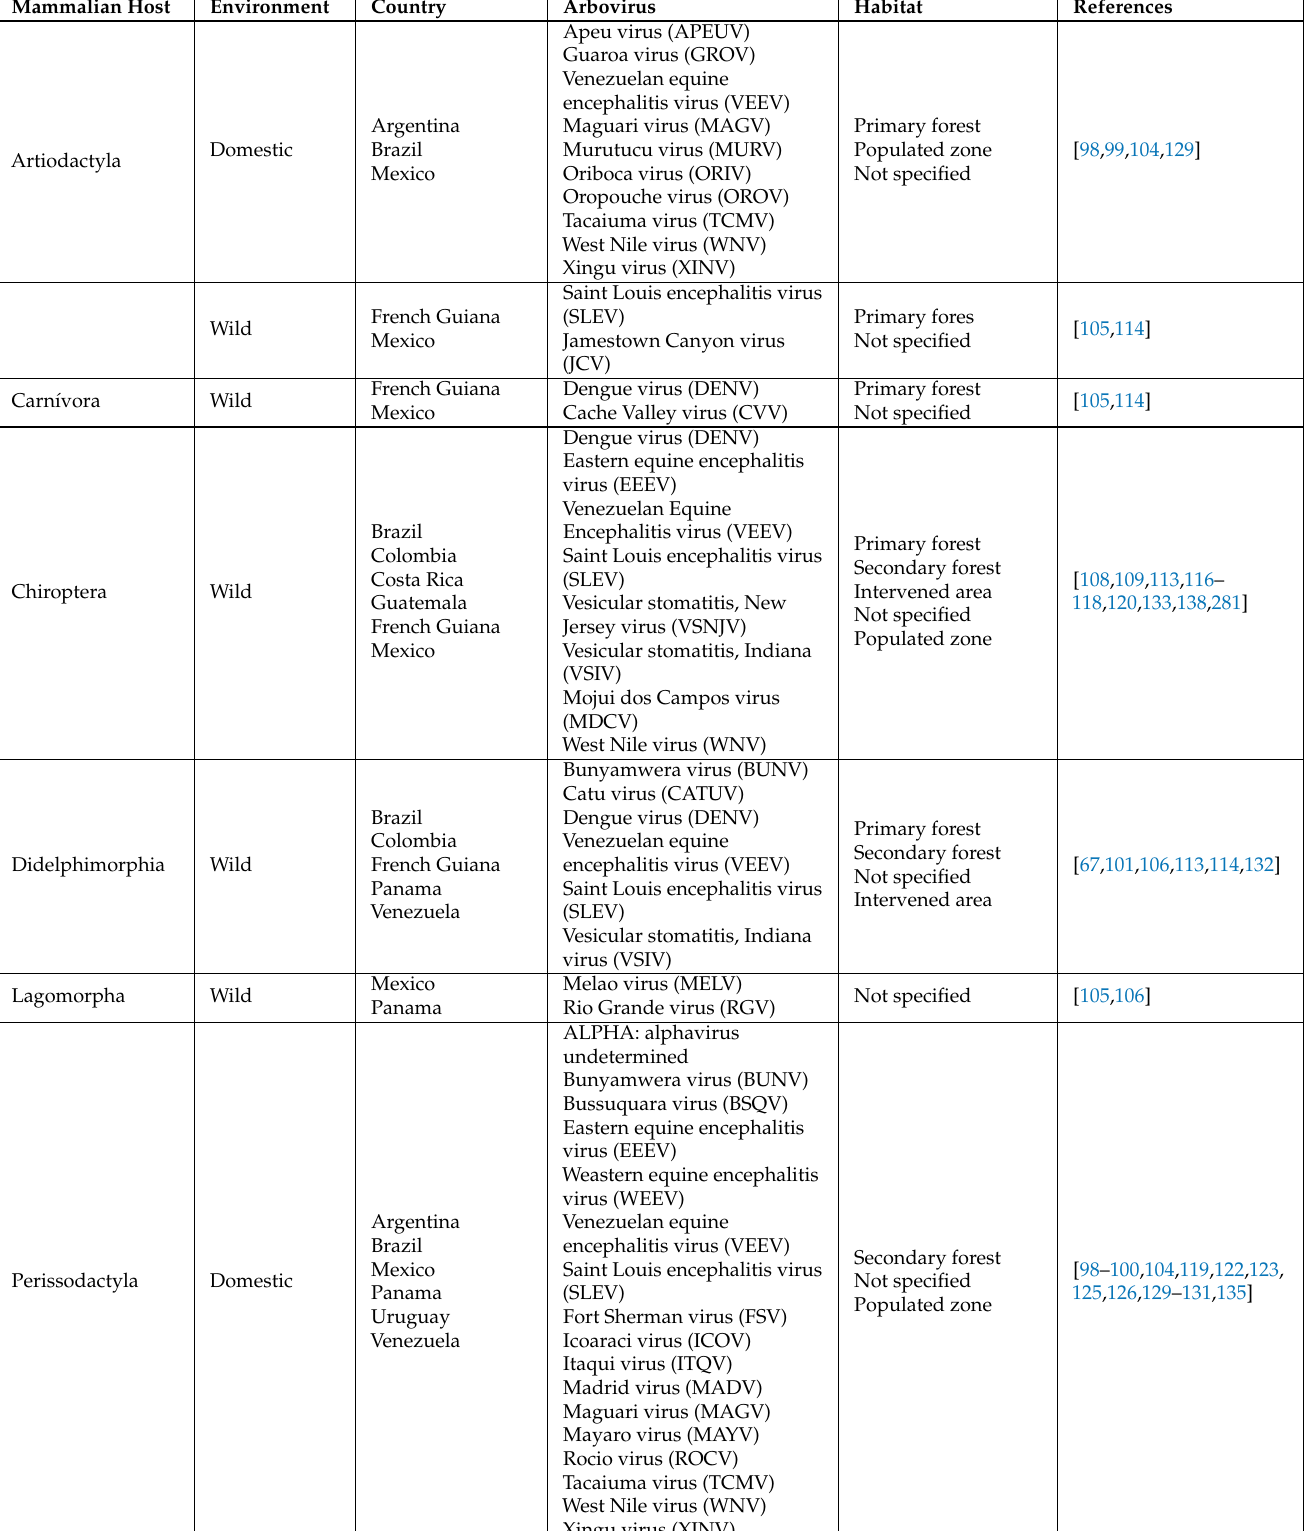
Table A1. Mammalian orders with arbovirus-positive records by habitat and